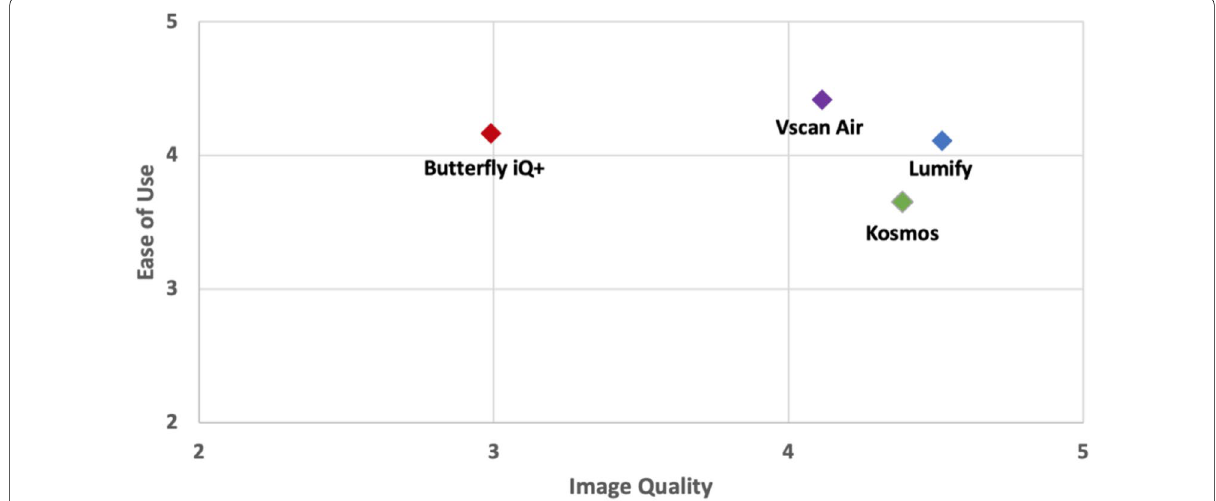
Fig. 1 Mean ratings of handheld ultrasound devices by ease of use and image